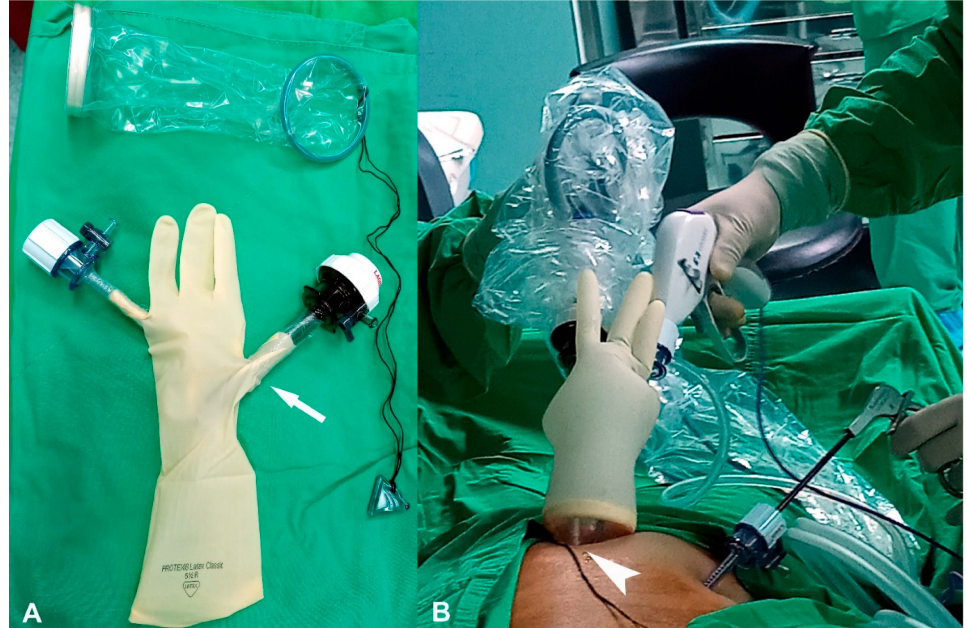
Figure 1. Two-port method of laparoscopic surgery. An XS Alexis wound retractor is placed through the umbilical wound, and the wound retractor rim is covered by a size-7 surgical glove. A 10 mm trocar and a 5 mm trocar are inserted into the glove fingers. Under laparoscopic inspection, an assistant 5 mm trocar is inserted into the left lower or upper abdomen on the basis of the gravid uterus size. ( A ) The white arrow indicates that the trocar is outside the abdominal cavity. ( B ) The white arrowhead indicates that the laparoscope level is as high as the